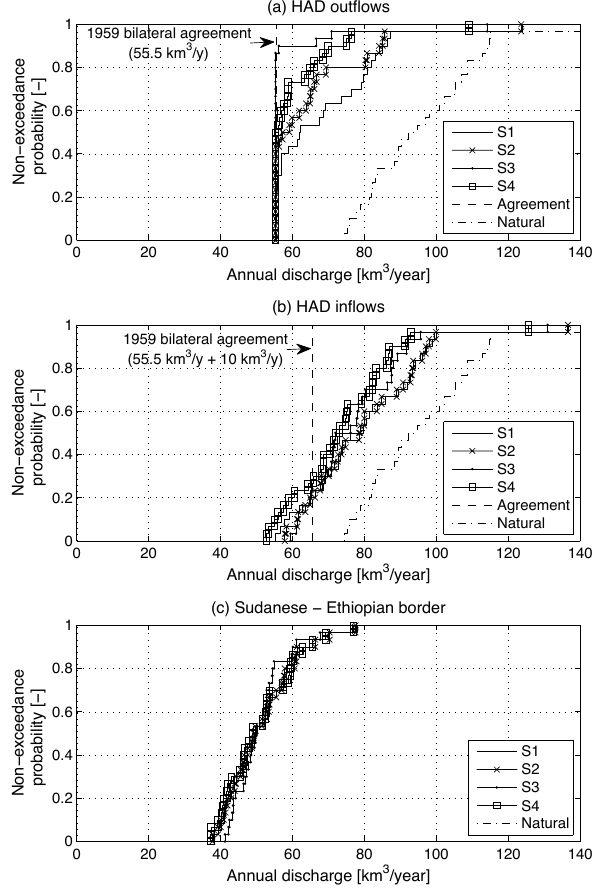
Fig. 7. Empirical cumulative distribution function (CDF) of the annual discharge at key locations. (a) High Aswan Dam outflows, (b) High Aswan Dam inflows and (c) Sudanese – Ethiopian border.